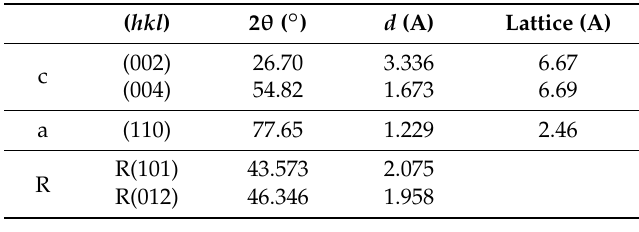
Figure 3. X-ray diffraction pattern of graphite with the assigned ( hkl ) Miller indices.